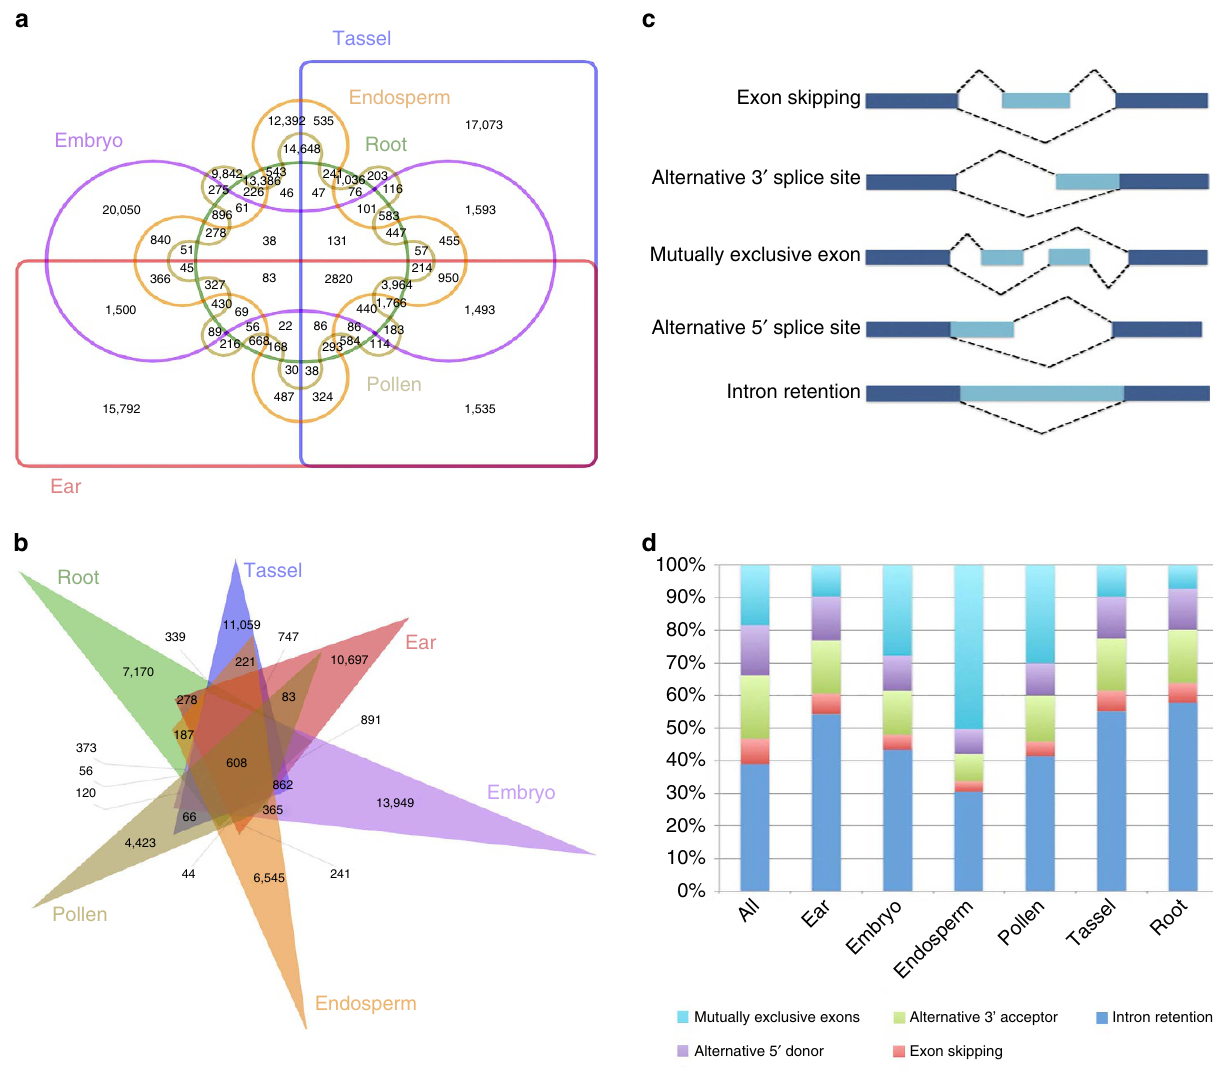
Figure 3 | Comparison of different isoforms among six tissues and different alternative splicing modes. ( a ) Overlap of all PacBio isoforms in six tissues. ( b ) Overlap of novel isoforms among six tissues. ( c ) Visualization of five alternative splicing modes. ( d ) Distribution of different types of alternative splicing events in six